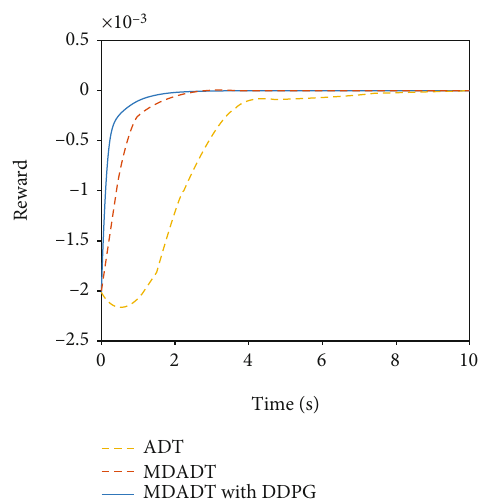
Figure 10: The response of episode